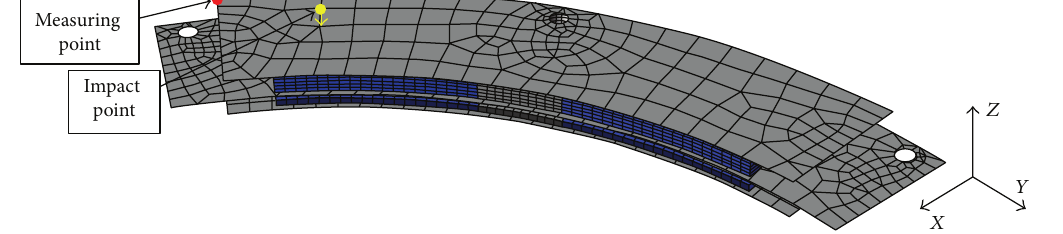
Figure 9: Theoretical model of the CLD with the impact and measurement points.